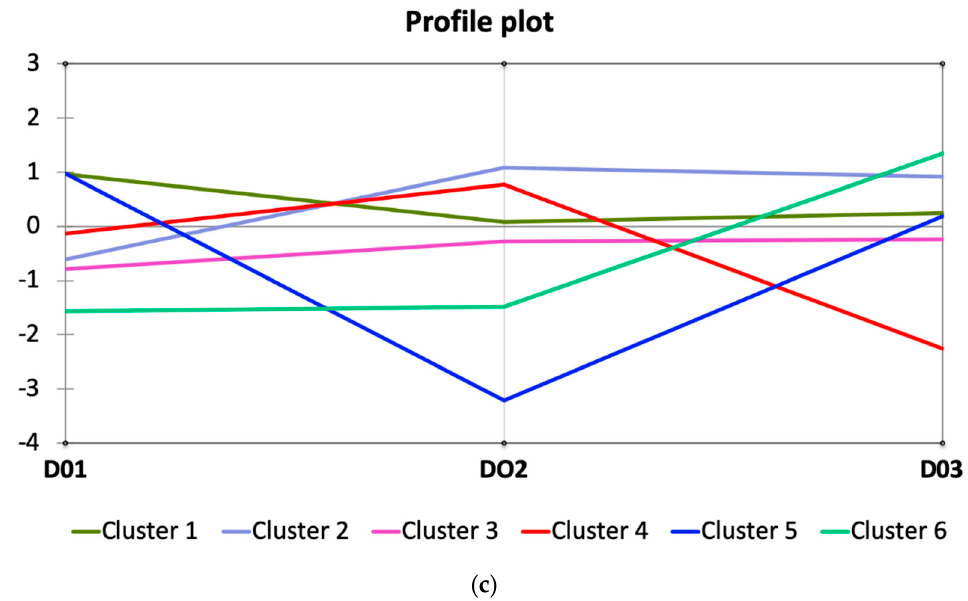
Figure 6. Agglomerative hierarchical clustering (AHC): Students’ opinions regarding the use of BIM and the skills acquired during the second implementation phase. ( a ) Evolution of variance; ( b ) dendrogram and ( c ) profile plot.